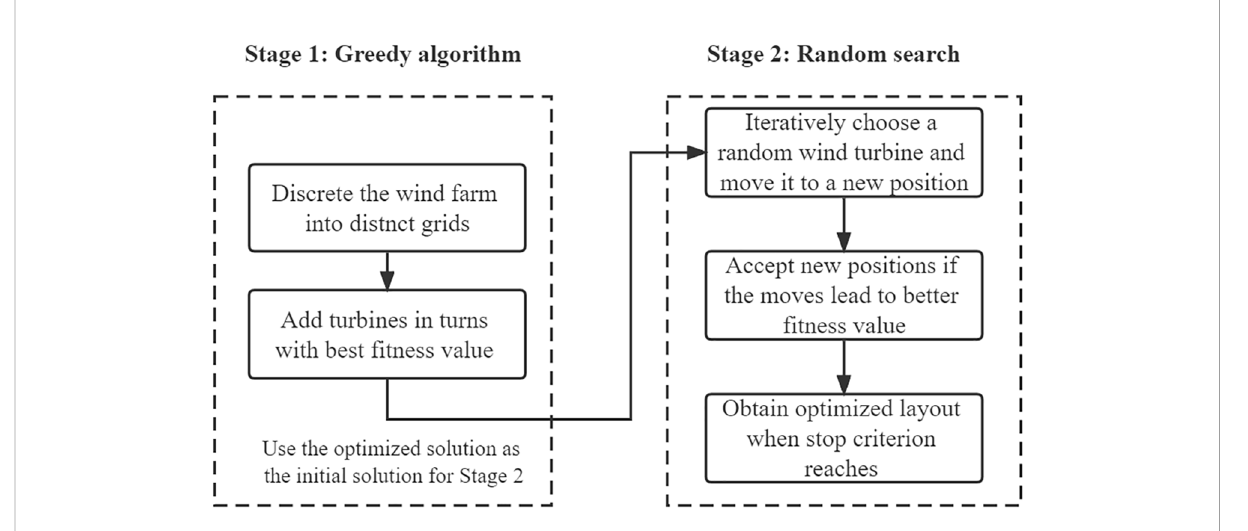
FIGURE 3 Flowchart of the proposed multi-stage